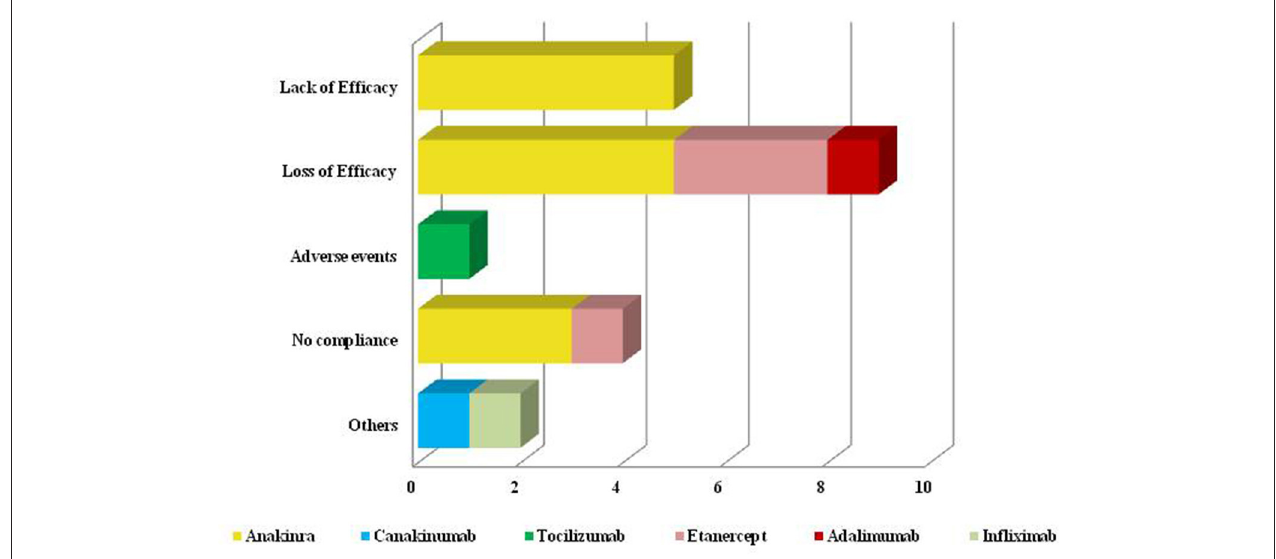
FIGURE 7 | Reasons for biologic discontinuation. Graphical representation of reasons leading to biologic treatment discontinuation. As better explained in the text ( Cause of biologic withdrawal and safety concerns ), the term “Others” includes a patient experiencing the onset of inflammatory bowel disease during canakinumab treatment and a patient experiencing paradoxical flares after infliximab administrations.